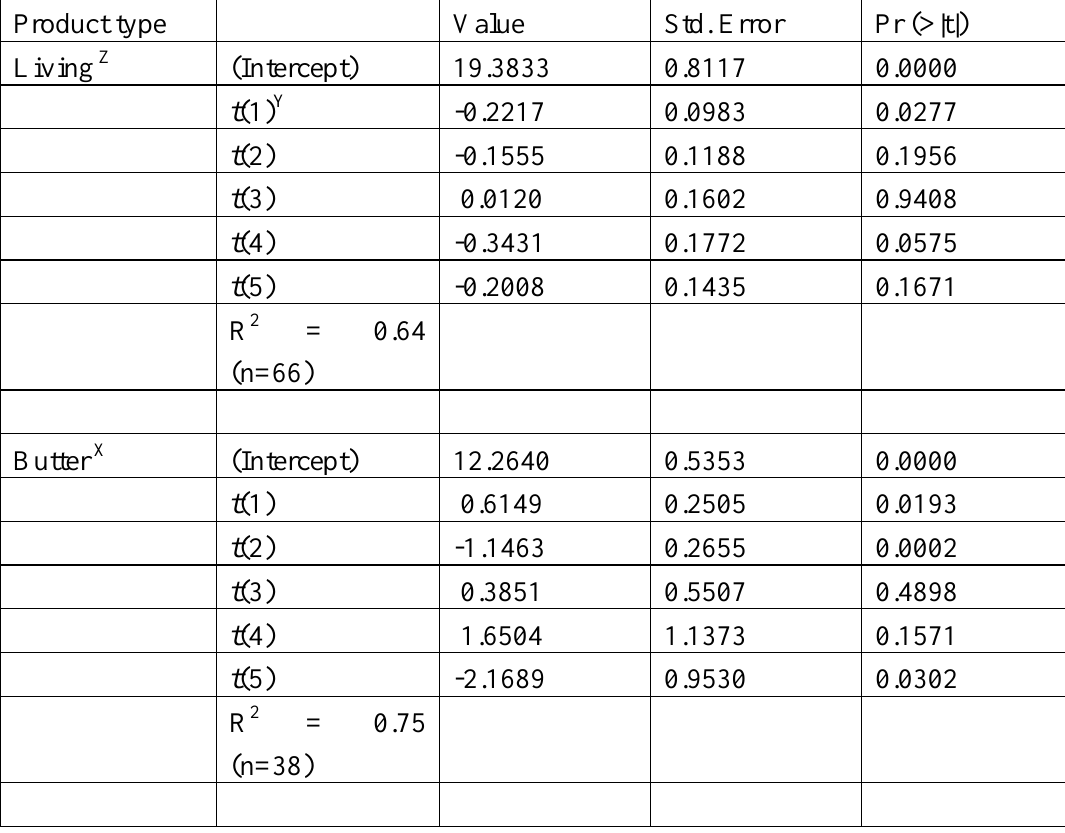
Table 2. Linear regression models for shelf life of living and butter